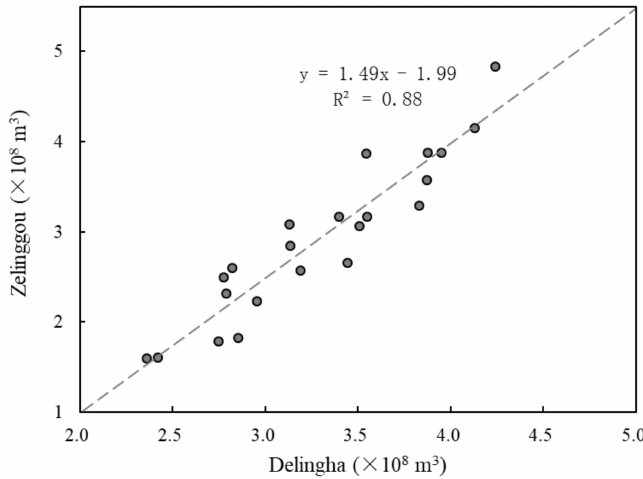
Figure 6. Graph representing the comparison between runoff at Delingha and Zelinggou stations from 1957 to